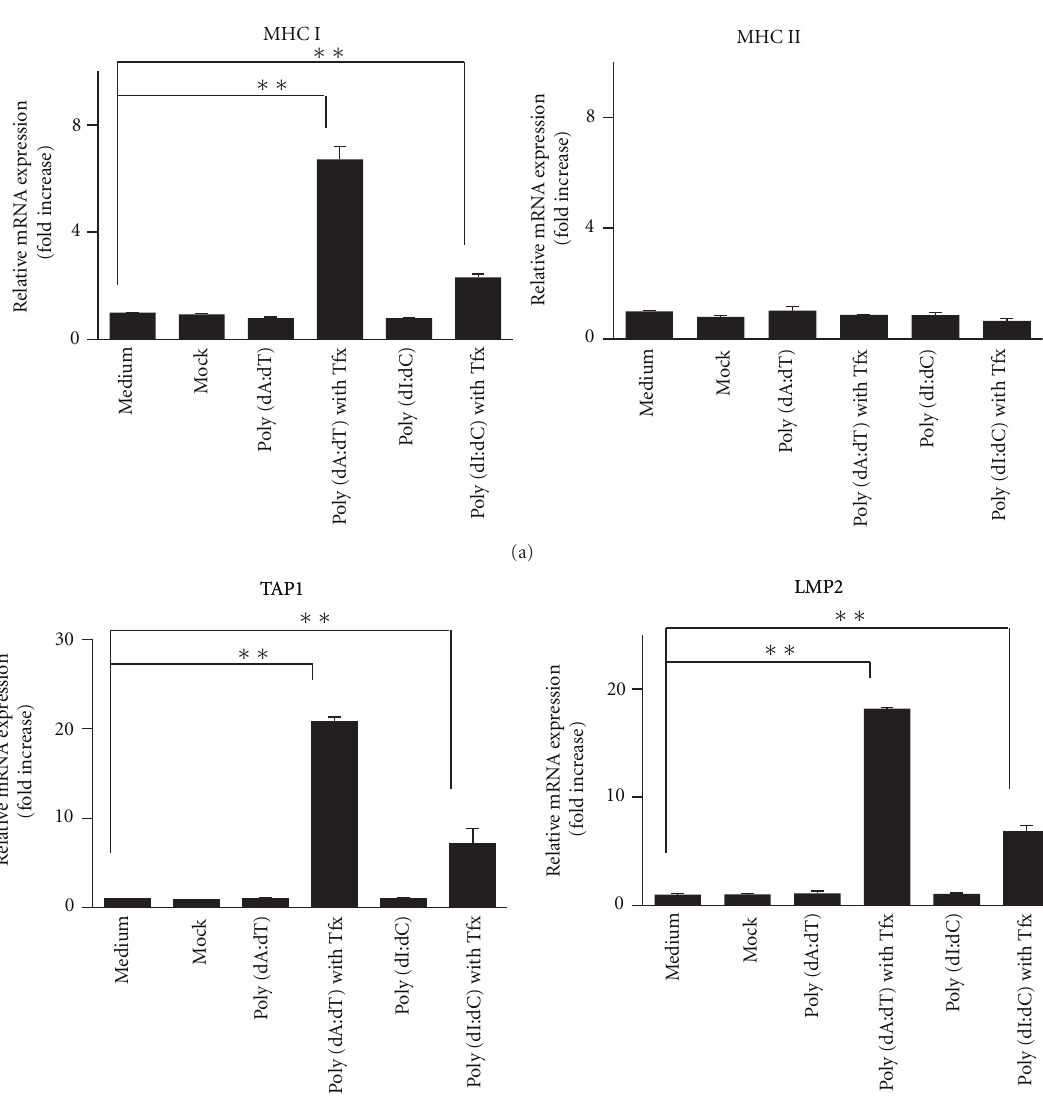
(b) Figure 3: Major histocompatibility complex (MHC) mRNA transcription is induced by synthetic double-stranded DNA (dsDNA). (a) Extracellular DNA (at 10 μ g/mL) stimulation has no e ff ect on MHC class I and class II. In contrast, intracellular dsDNA (at 10 μ g/mL) increased expression of their transcriptional factors transporter associated with antigen processing 1 (TAP1) and low-molecular-weight protein 2 (LMP2) (b). TFx: + transfection reagent lipofectamine. ∗ P < 0 . 05, ∗∗ P < 0 .